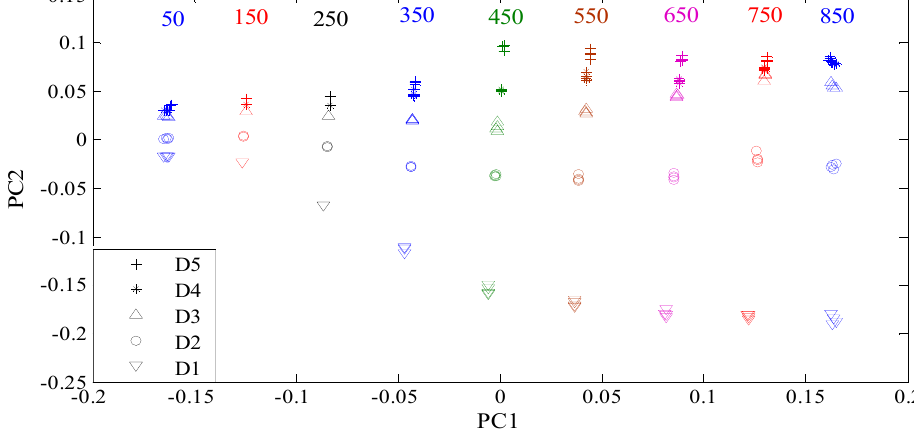
Figure 7. Features of the defects with different depths.